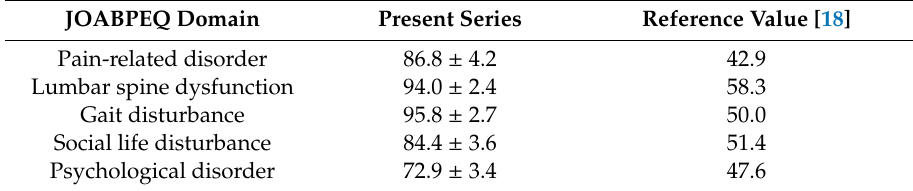
Table 4. Comparison of JOABPEQ scores with reference values for low back pain